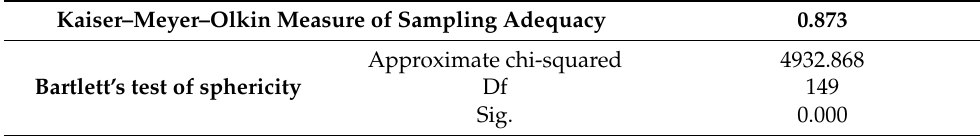
Table 12. KMO and Bartlett’s test for the influencing factor questions